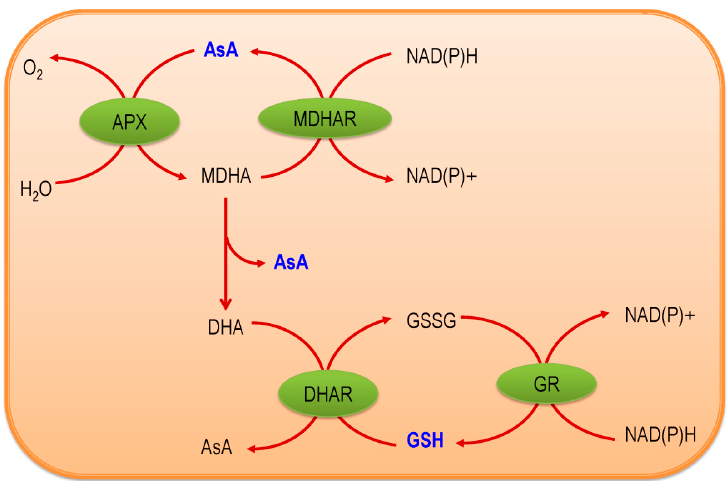
Figure 1. Ascorbate-Glutathione (AsA-GSH) (Ascorbate-Glutathione) pathway [ascorbate, AsA; ascorbate peroxidase, APX; monodehydroascorbate, MDHA; monodehydroascorbate reductase, MDHAR; dehydroascorbate, DHA; dehydroascorbate reductase, DHAR; glutathione, GSH; oxidized glutathione, GSSG; glutathione reductase, GR; Nicotinamide adenine dinucleotide phosphate (reduced form), NAD(P)H; Nicotinamide adenine dinucleotide phosphate (oxidized form), NAD(P) +